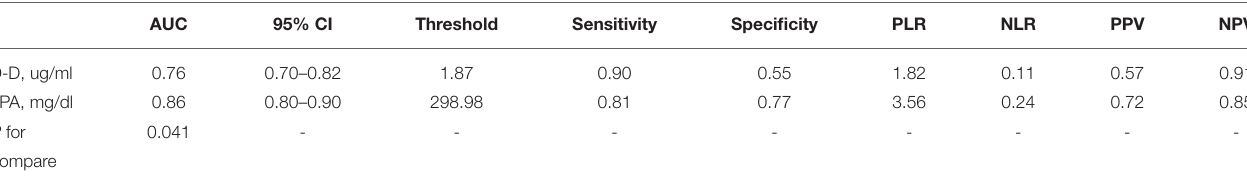
TABLE 3 | Diagnostic performance of AAD patients vs. others using LPA compared with D-Dimer. AUC 95% CI